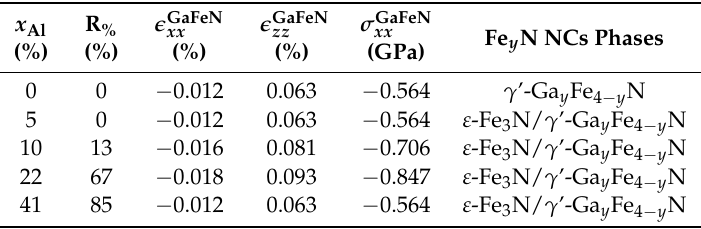
Table 1. List of investigated samples and their relevant parameters: Al concentration x Al in